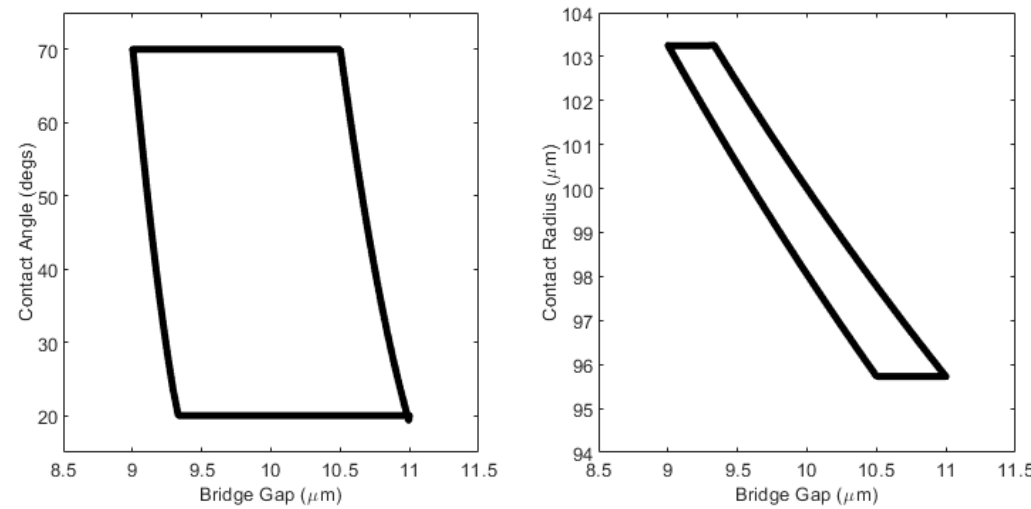
Figure 11. Variation of contact angle (left) and contact line radius (right) as a function of gap for the bridge detailed in Figure 10 (left).